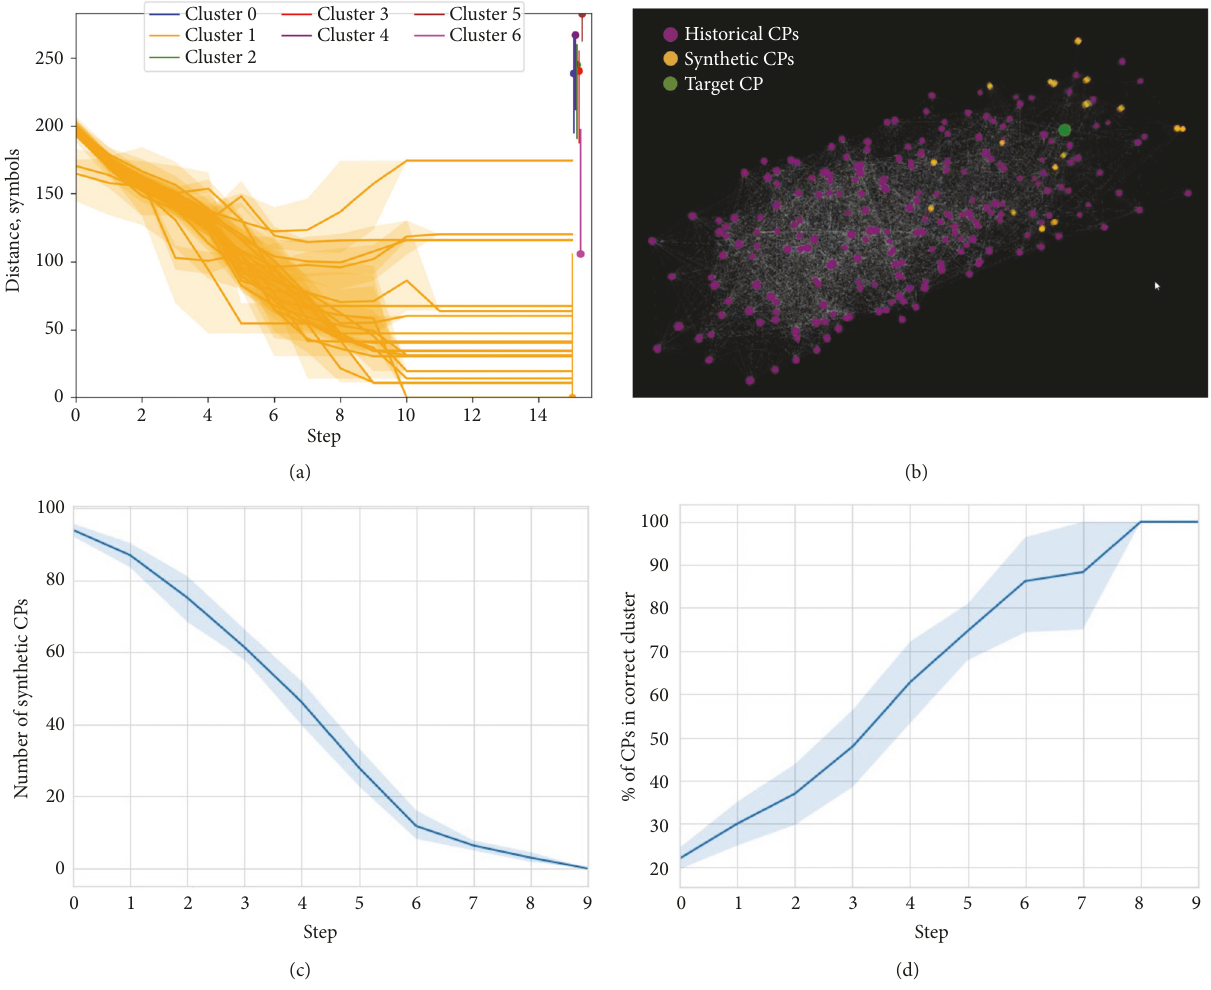
Figure 10: Evolution of synthetic CPs: (a) CP population convergence; (b) evolution of possible CP (demonstration available at https://www .youtube.com/watch?v=twvfX9zKsY8); (c) number of synthetic CPs; (d) % of CPs in correct